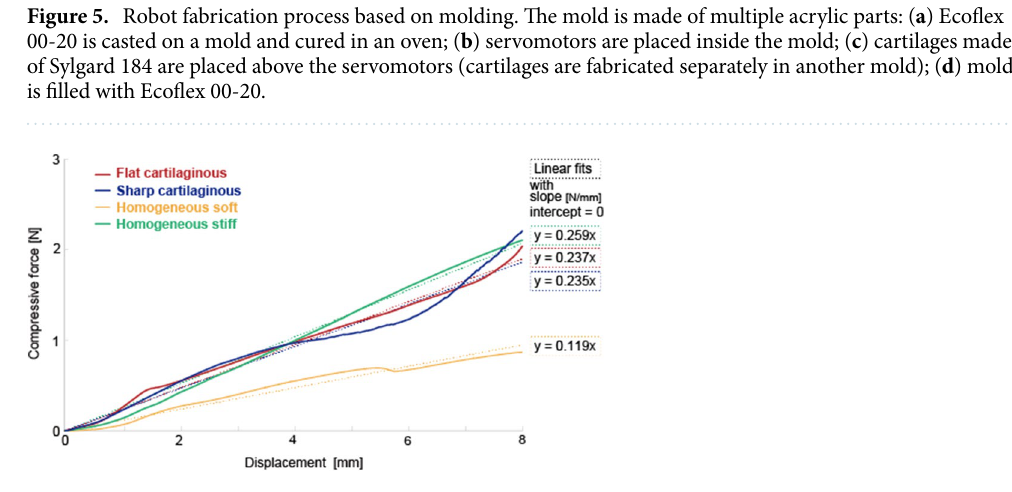
Figure 6. Result of customized bulk bending test of the fabricated robots. Solid lines represent the measured data, and dashed lines are their linear